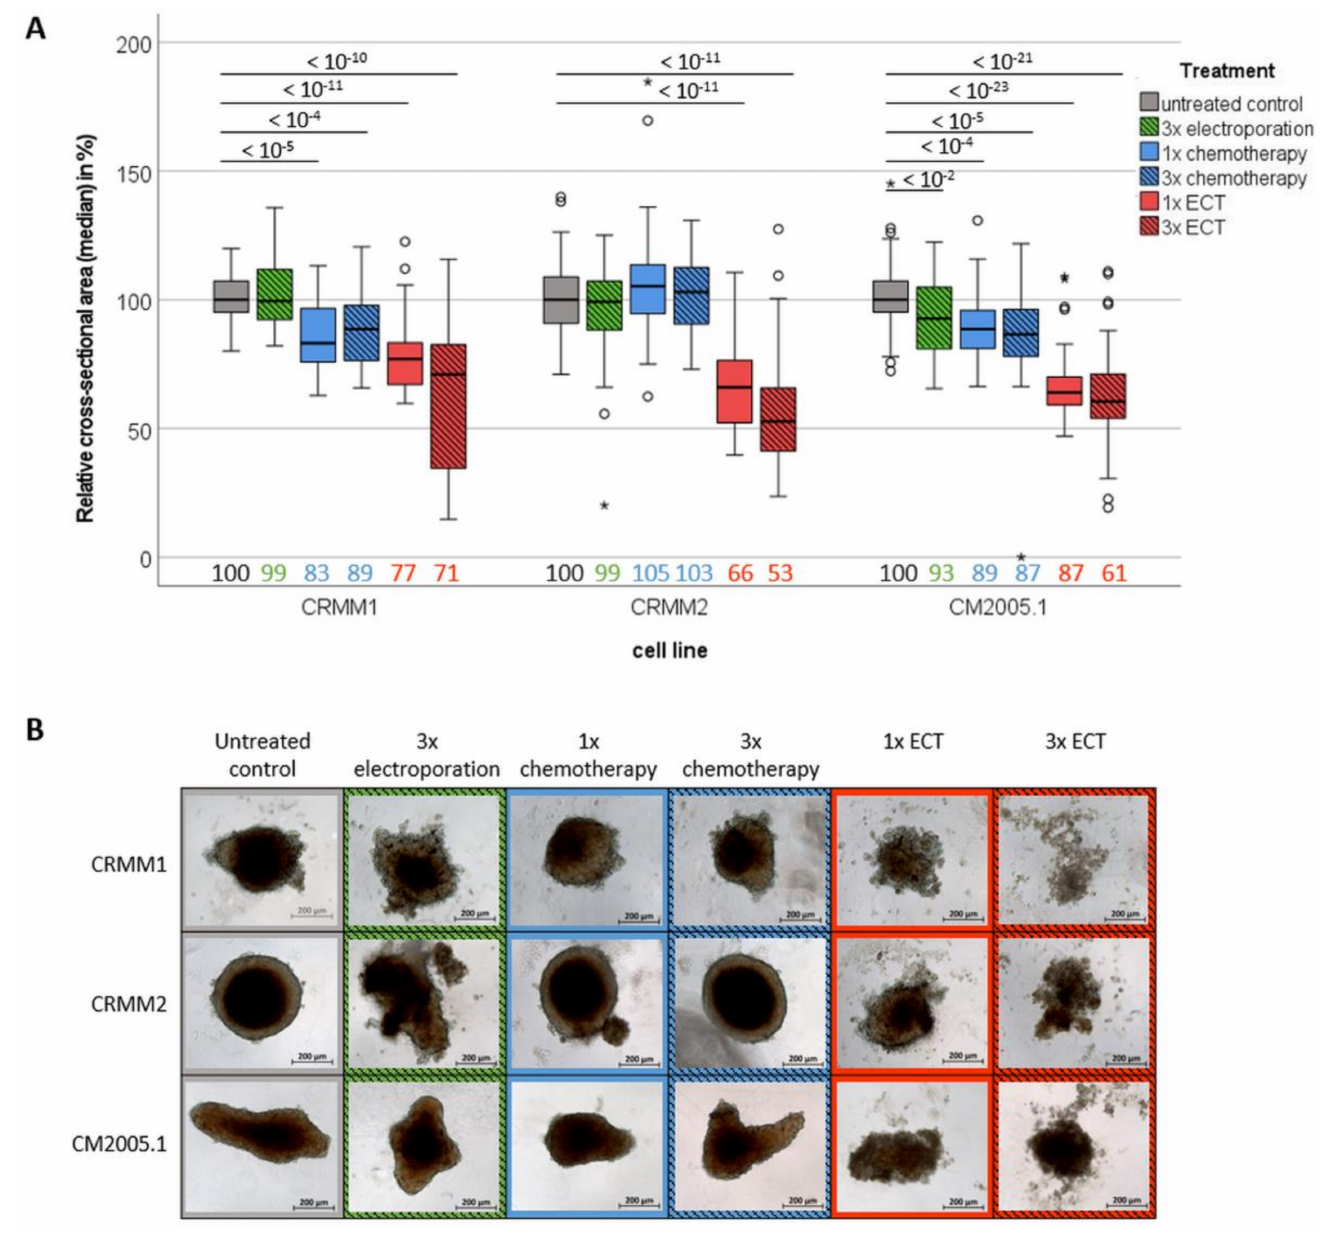
Figure 2. Comparison of spheroid size of different conjunctival cell lines on day 7 after different treatment options. ( A ) Boxplot of the relative cross-sectional area after different treatment options compared to untreated controls. Median values are listed on the bottom side of the boxplot. Statistical differences are stated above using p -Values (*); ( B ) Representative live images of spheroids after different treatment options. Scale bar = 200 µ m. Abbreviations: ECT =